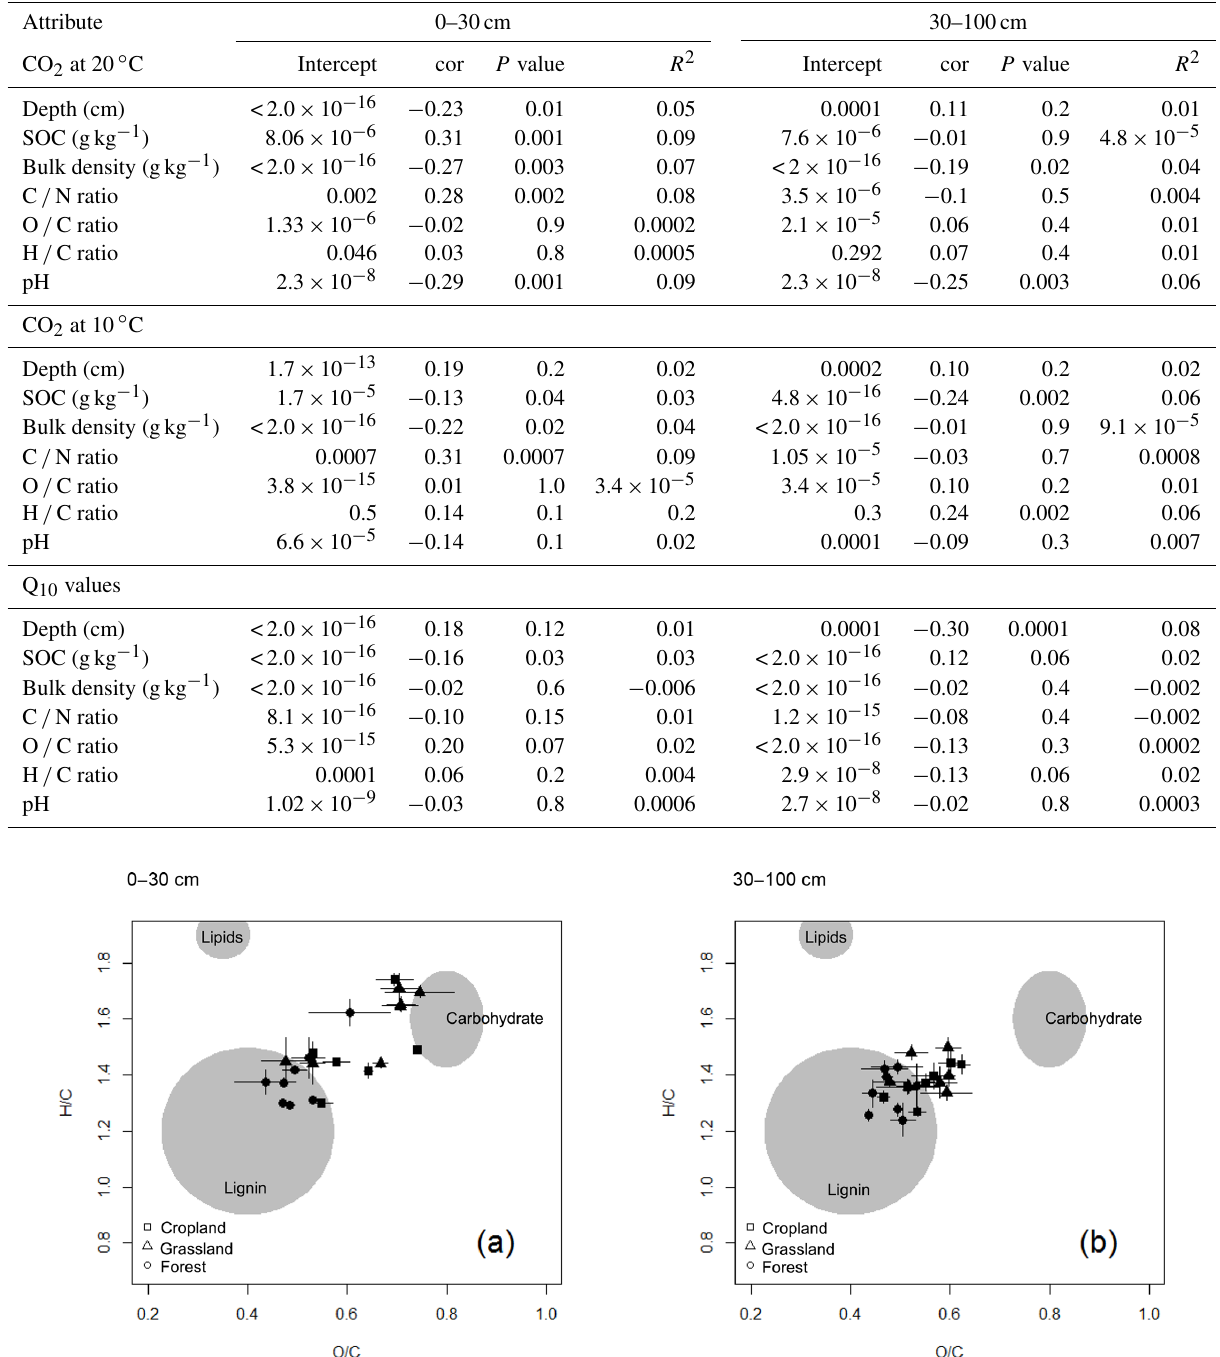
Figure 2. Van Krevelen plots of samples from (a) the upper 30cm and (b) depths below 30cm. Symbols represent averages for relevant core segments from each site, black bars represent the standard error of the mean, grey surfaces represent the range of O / C and H / C for lignin, carbohydrates and lipids, adapted from Preston and Schmidt